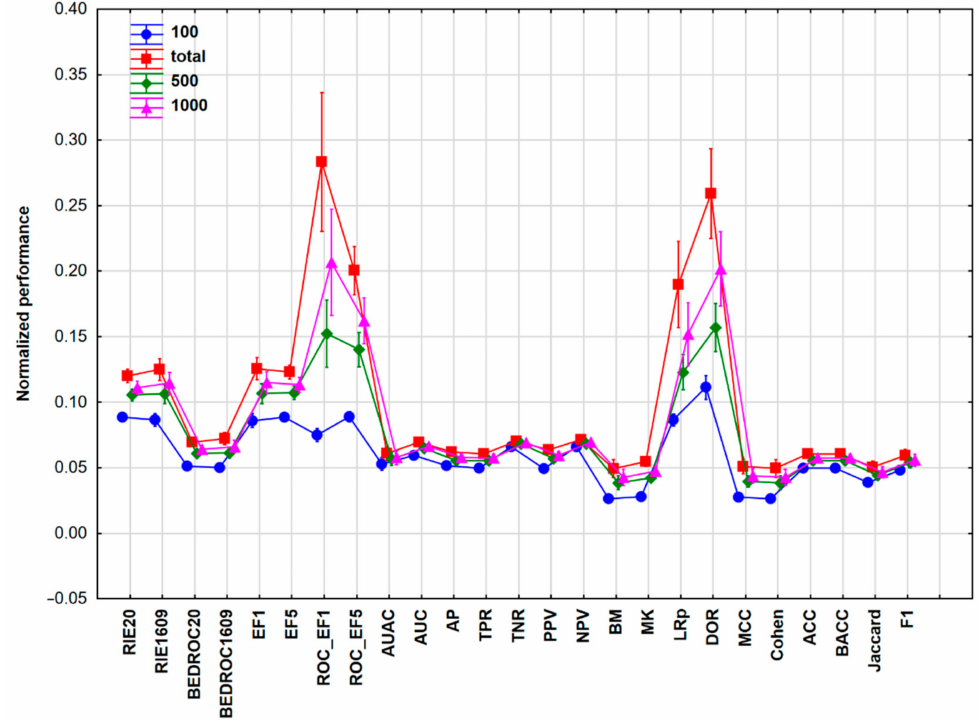
Figure 1. The average scaled values of the different performance parameters with the 95% confidence intervals for Case study 1. Normalization of performance parameters was necessary to be comparable. Number of samples (NS) is 100 (blue circles), 500 (green diamonds), 1000 (purple triangles), or total (2710, red squares). Abbreviations are explained in table from Section